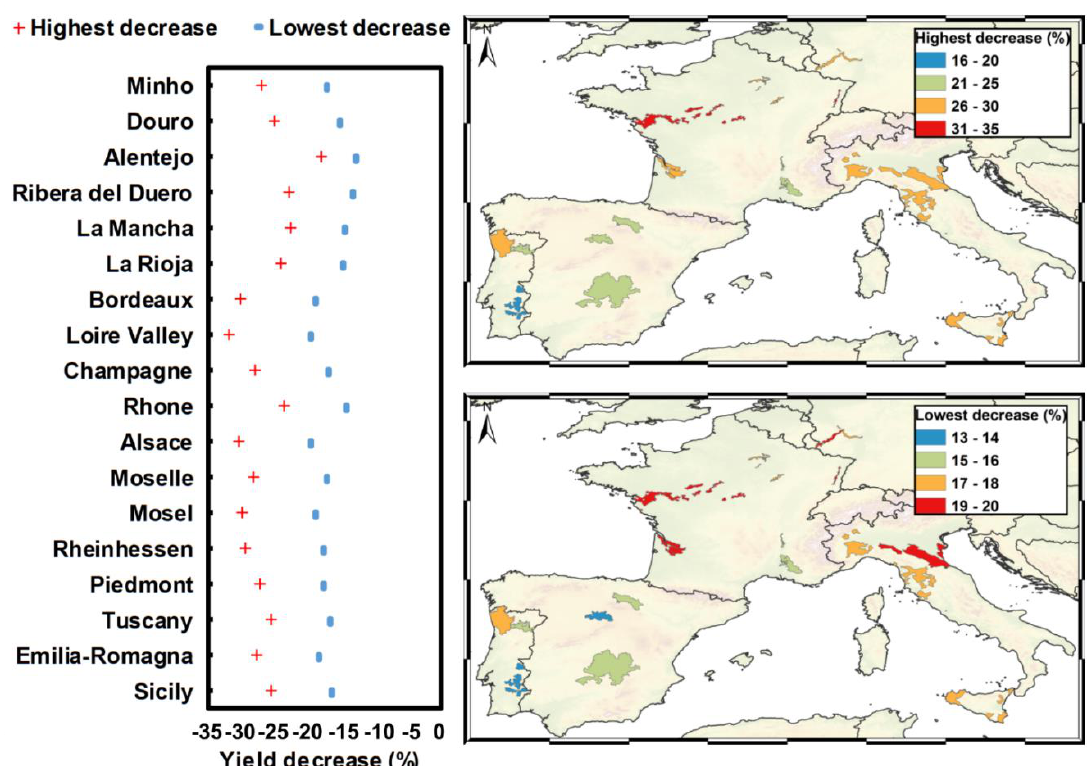
Figure 5. Left panel : highest and lowest yield decrease due to heatwaves for each winemaking region at the peak date. Right panel : geographical representation of the highest and lowest decrease in yields over Europe at the peak date.